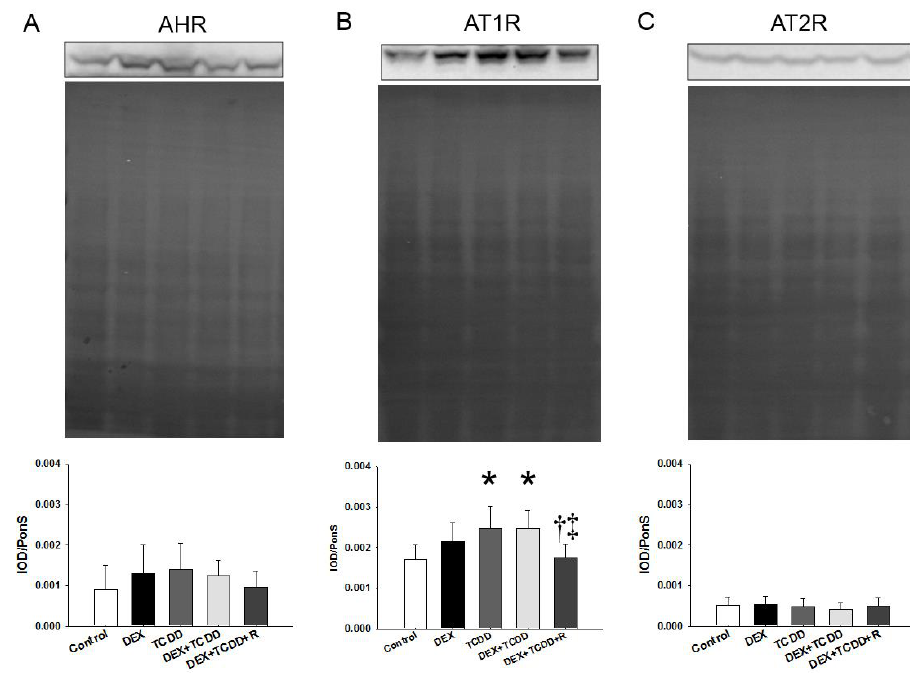
Figure 4. Representative western blots, Ponceau red staining, and relative abundance of ( A ) AHR (96 kDa), ( B ) angiotensin II type 1 (AT1R, 43 kDa), and ( C ) type 2 receptor (AT2R, 50 kDa) in male offspring rats at 16 weeks of age. Data were analyzed by one-way ANOVA followed by Dunnett’s C post hoc test. * p < 0.05 versus control group; † p < 0.05 versus TCDD group; ‡ p < 0.05 versus DEX + TCDD group ( n = 7–8/group).